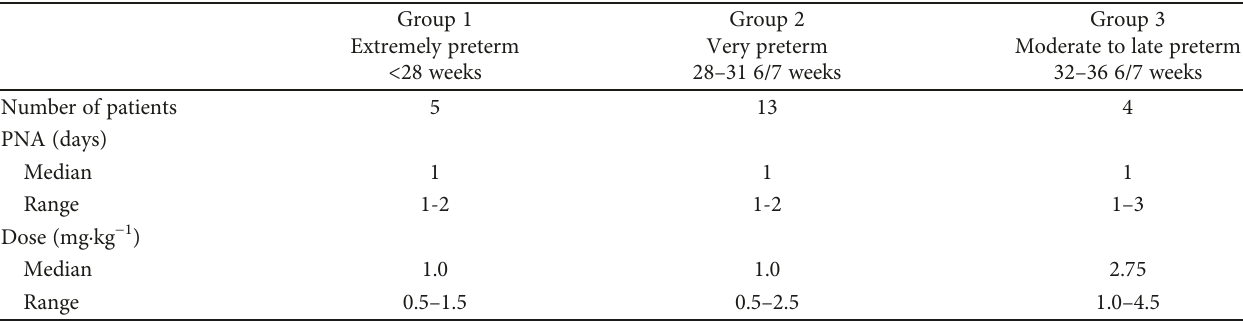
Table 1: Strati fi cation of the neonates into three age groups, based on postmenstrual age (PMA) in weeks. For each group, the number of patients, postnatal age (PNA) of the patients, and propofol dose values administered to the subjects in the group are